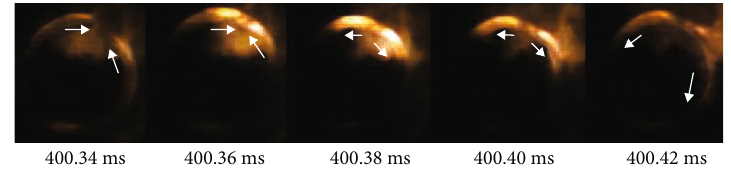
Figure 4: Rotating detonation events captured by a high-speed camera, 50000